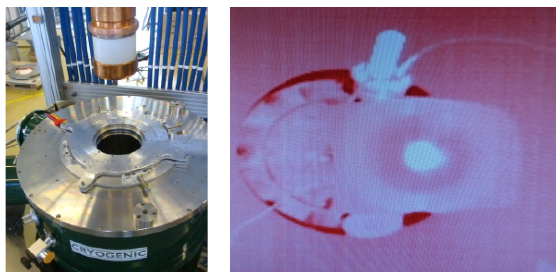
Fig. 12. On the left, SC magnet tope plate (reference plane), together with the XY table while installing the gyrotron. On the right, very short pulse centered at the output RF window.